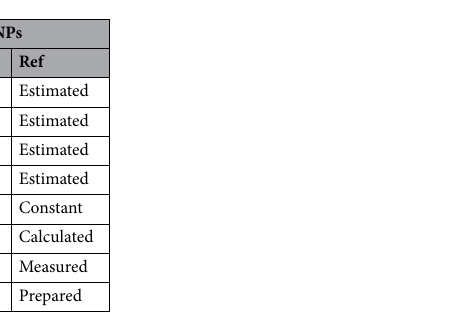
Table 1. Model parameter values for the catalytic reduction of Cr(VI).